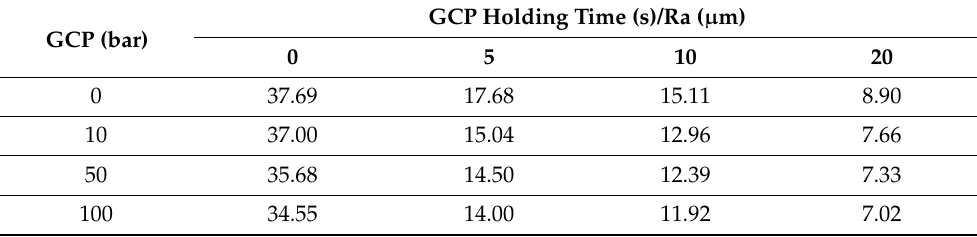
Table 3. Surface roughness measurements with different GCP and holding times on the middle position.